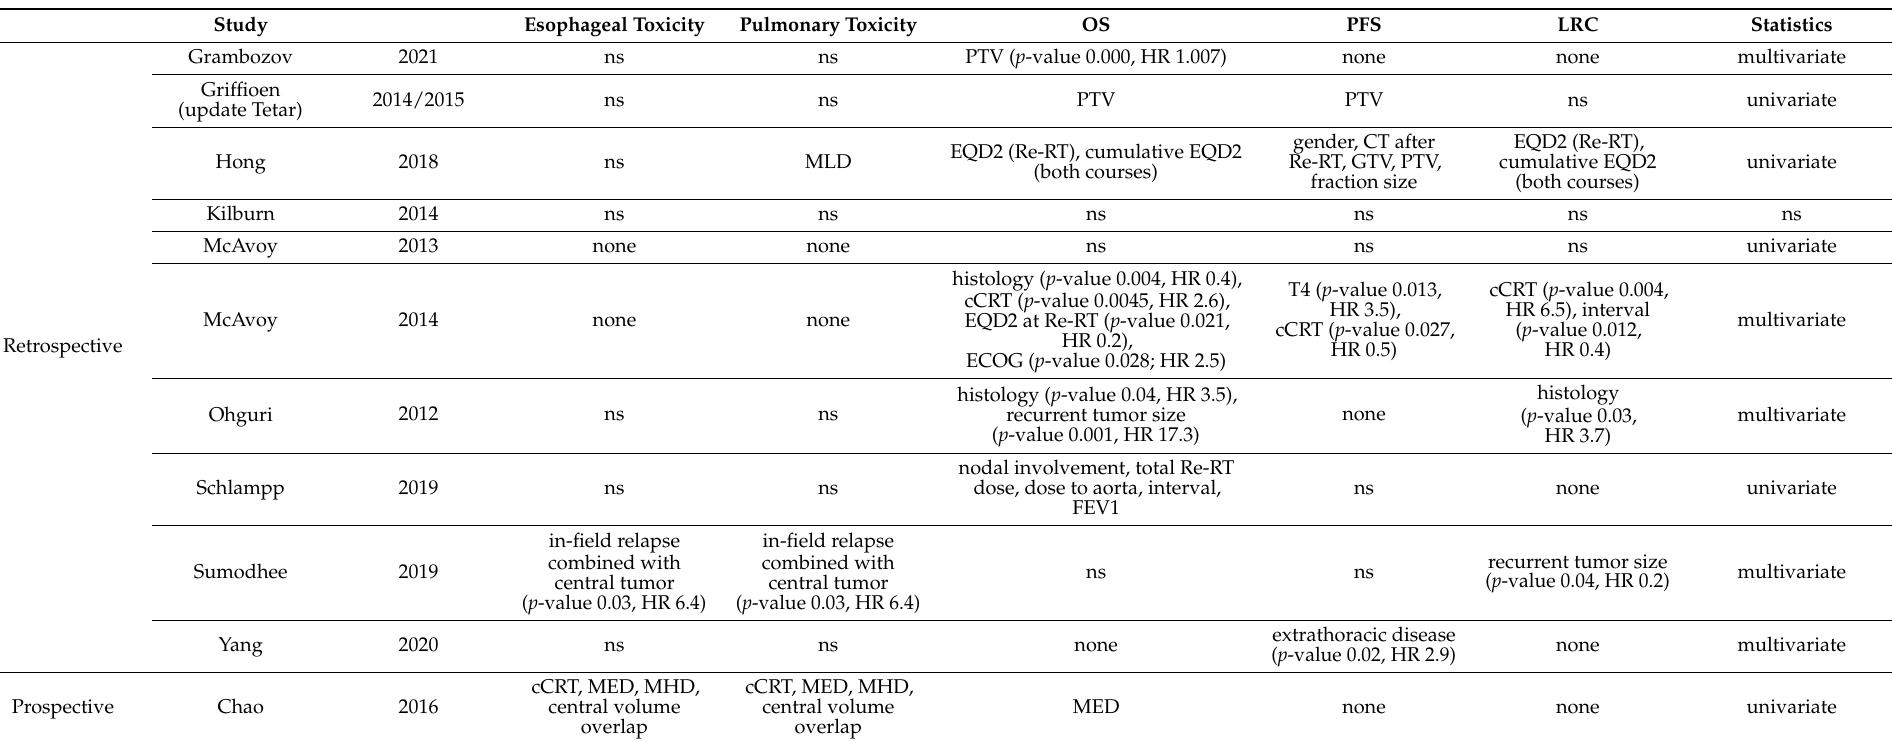
Table 5. Prognostic and predictive markers for toxicity and clinical